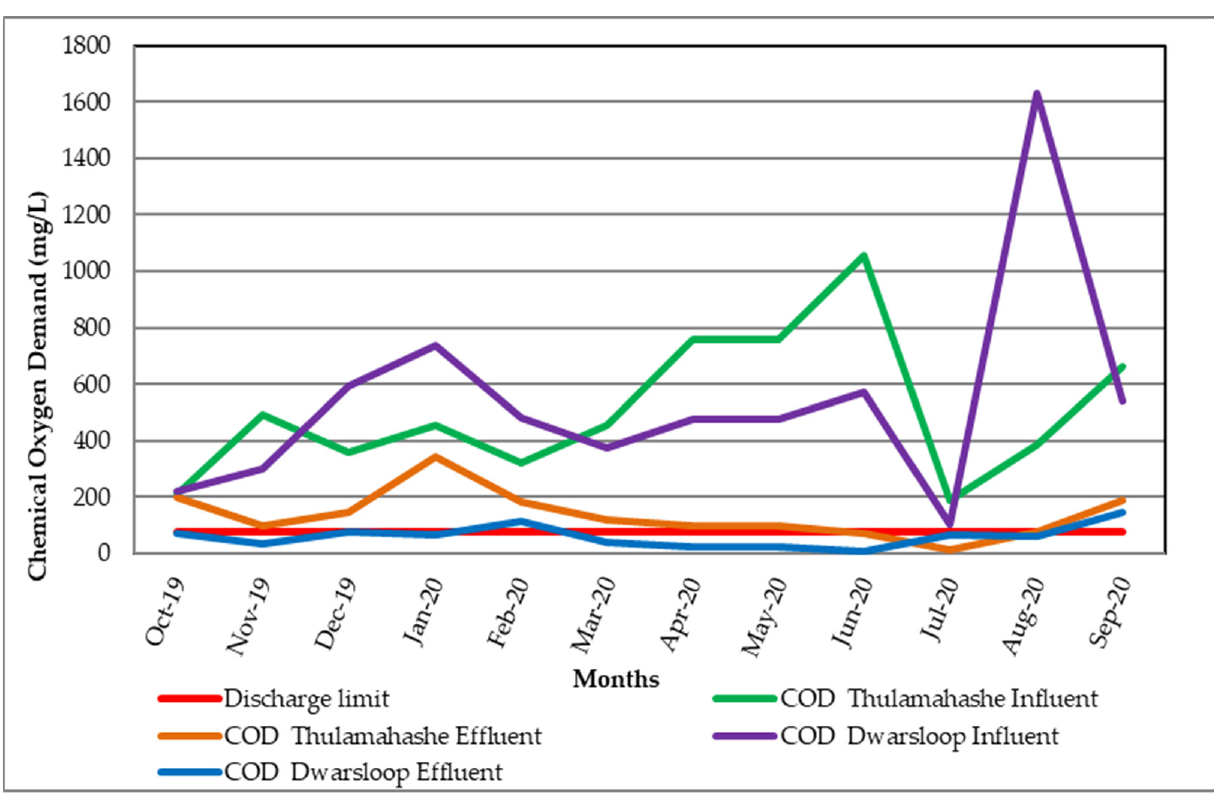
Figure 11. WWTWs performance in terms of chemical oxygen demand.